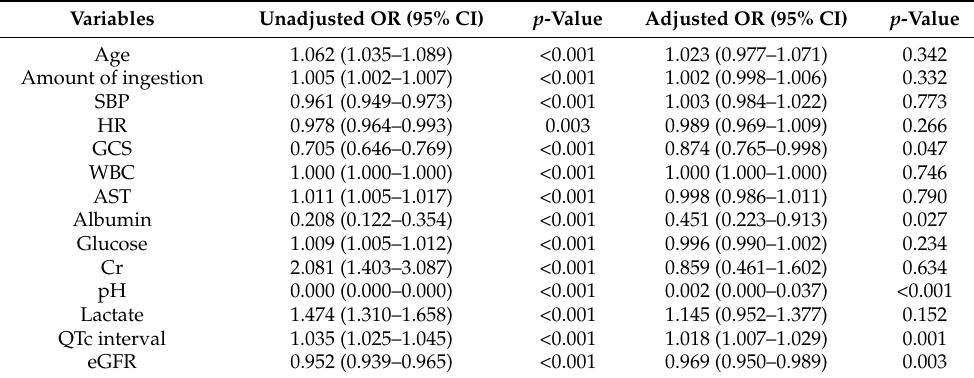
Table 3. Multivariable analysis of factors associated with in-hospital mortality.